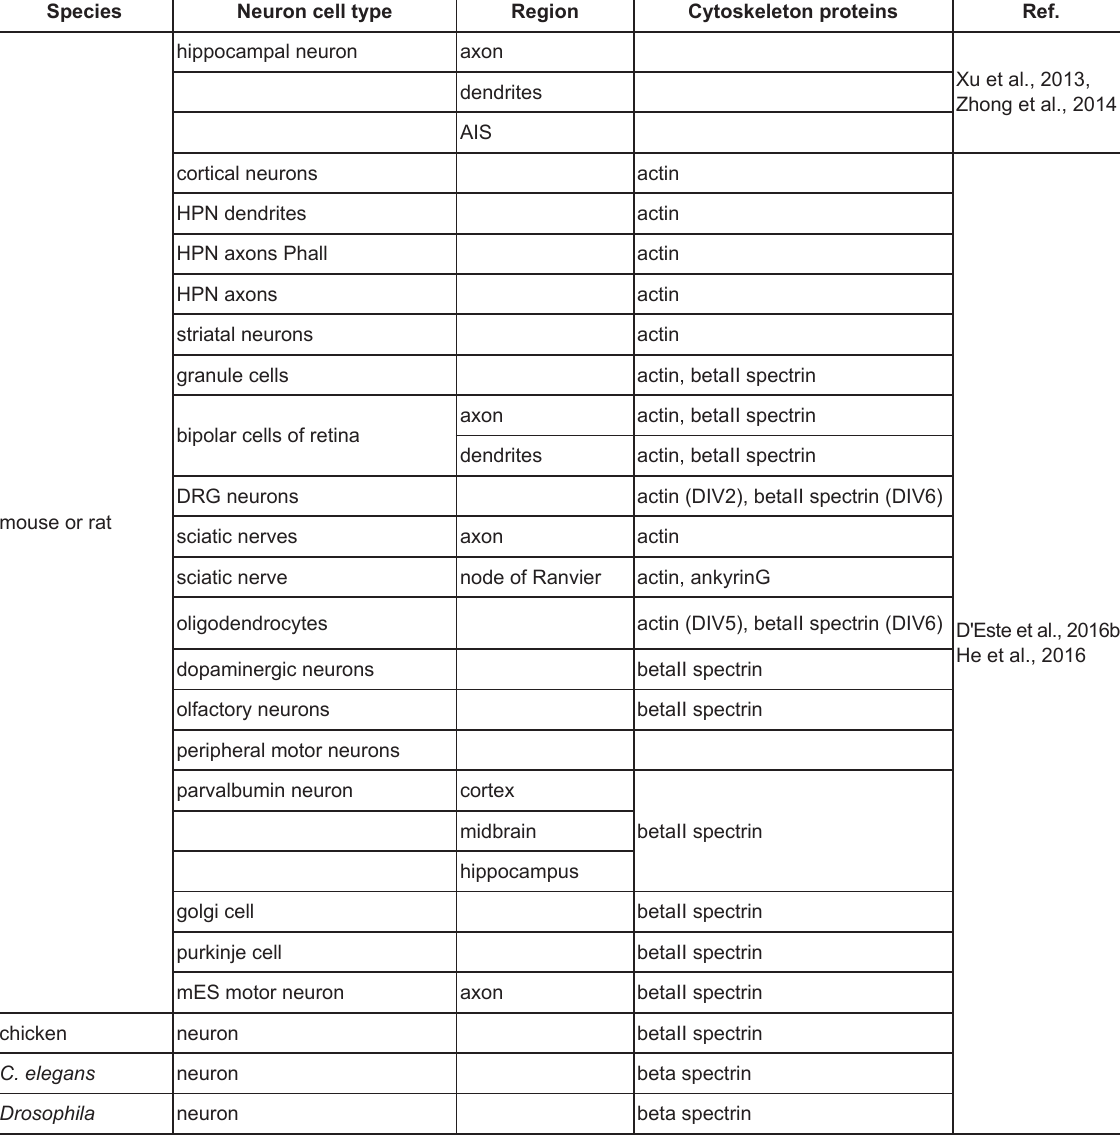
Table 1: the summary of periodic cytoskeleton structure in the different neuron cell